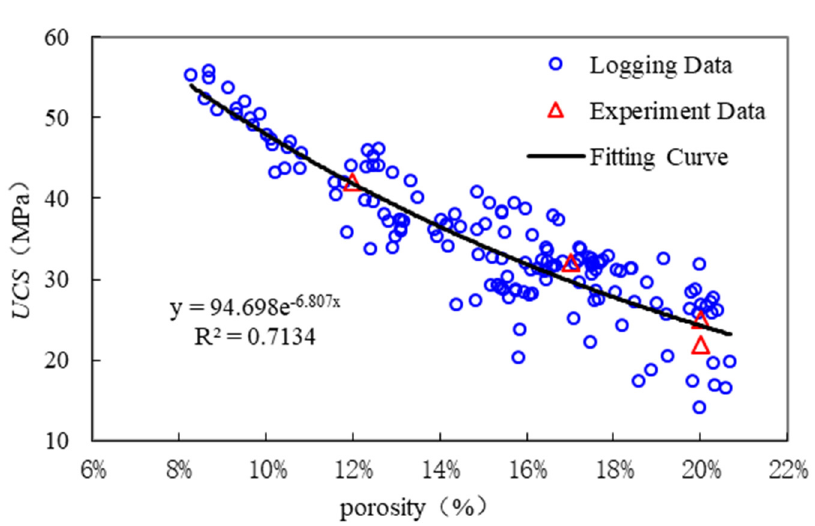
Figure 2. The relation between porosity and uniaxial compressive strength of sandstone.